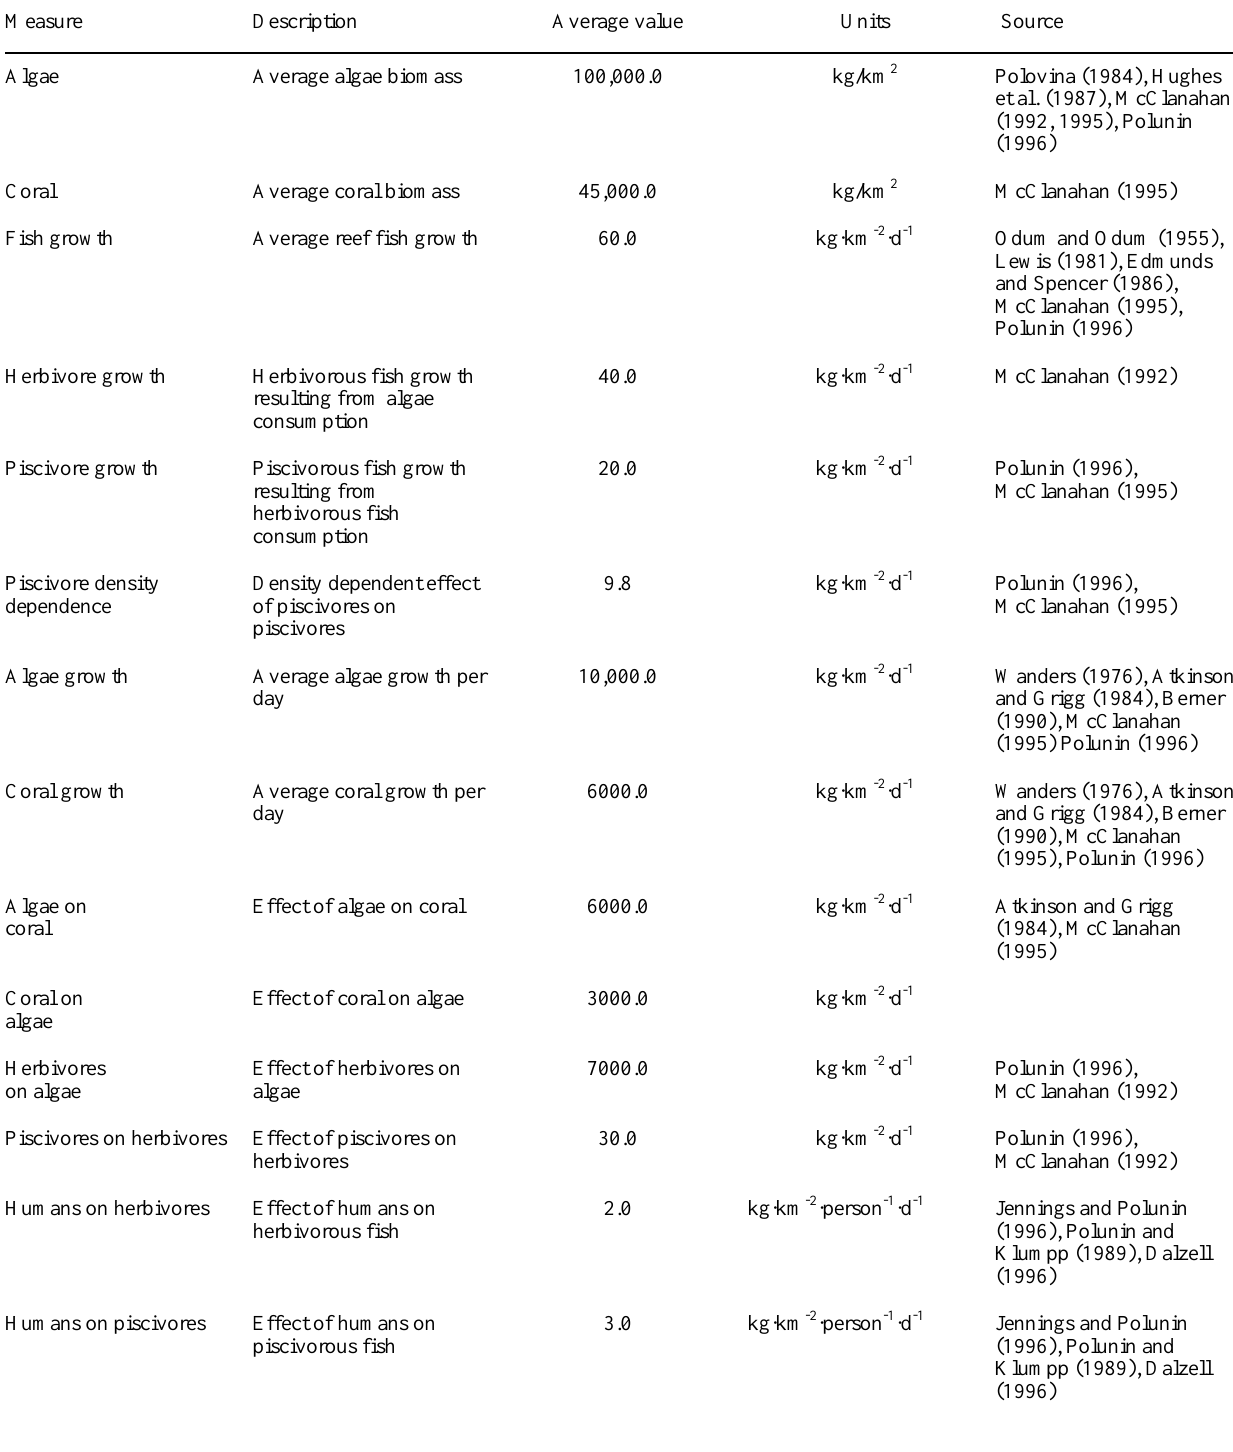
Table 1 . Values used to derive parameters for baseline